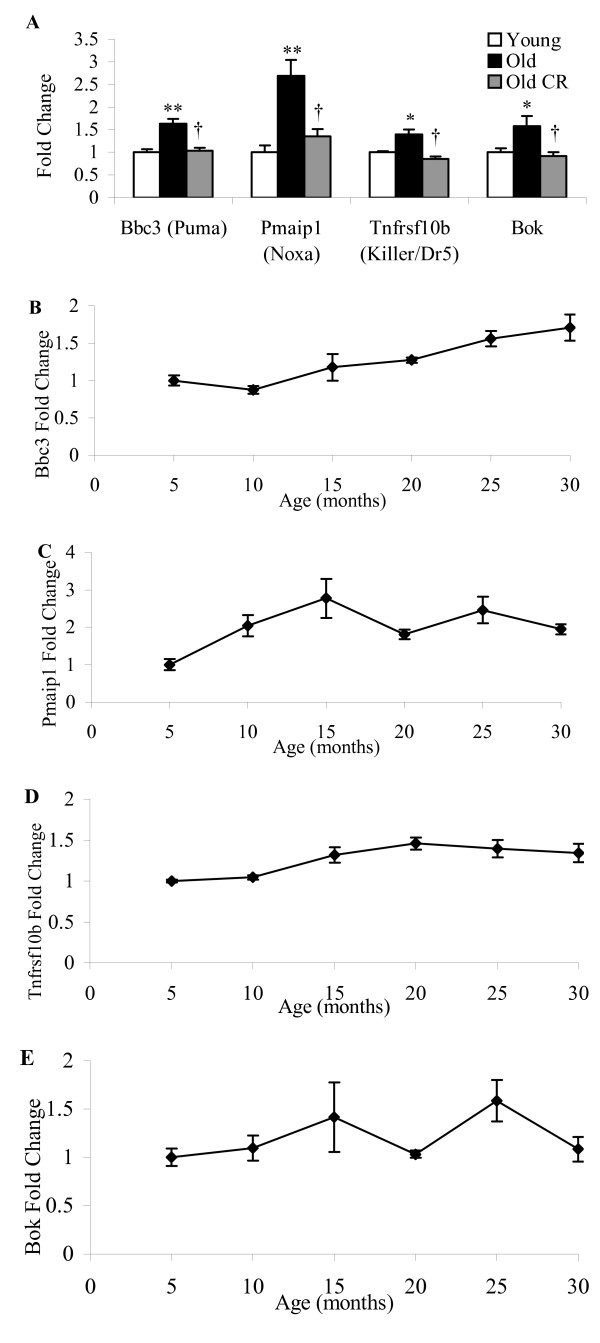
RT-PCR of proapoptotic bbc3, pmaip1, tnfrsf10b and bok expression in mouse skeletal muscle. (A) Relative expression ratio ± SE for mRNA levels of p53-mediated apoptotic genes in young, old, and old CR (n = 5 for each group). The mRNA levels for these four genes were also measured using RT-PCR in 5–30 month old C57BL/6NHsd mouse gastrocnemius muscle (B-E) (mean ± SE of 5 animals per age group). Two-tailed Student's t-test; *P < 0.05, **P < 0.005 (young verses old), †P < 0.05 (old versus old CR).